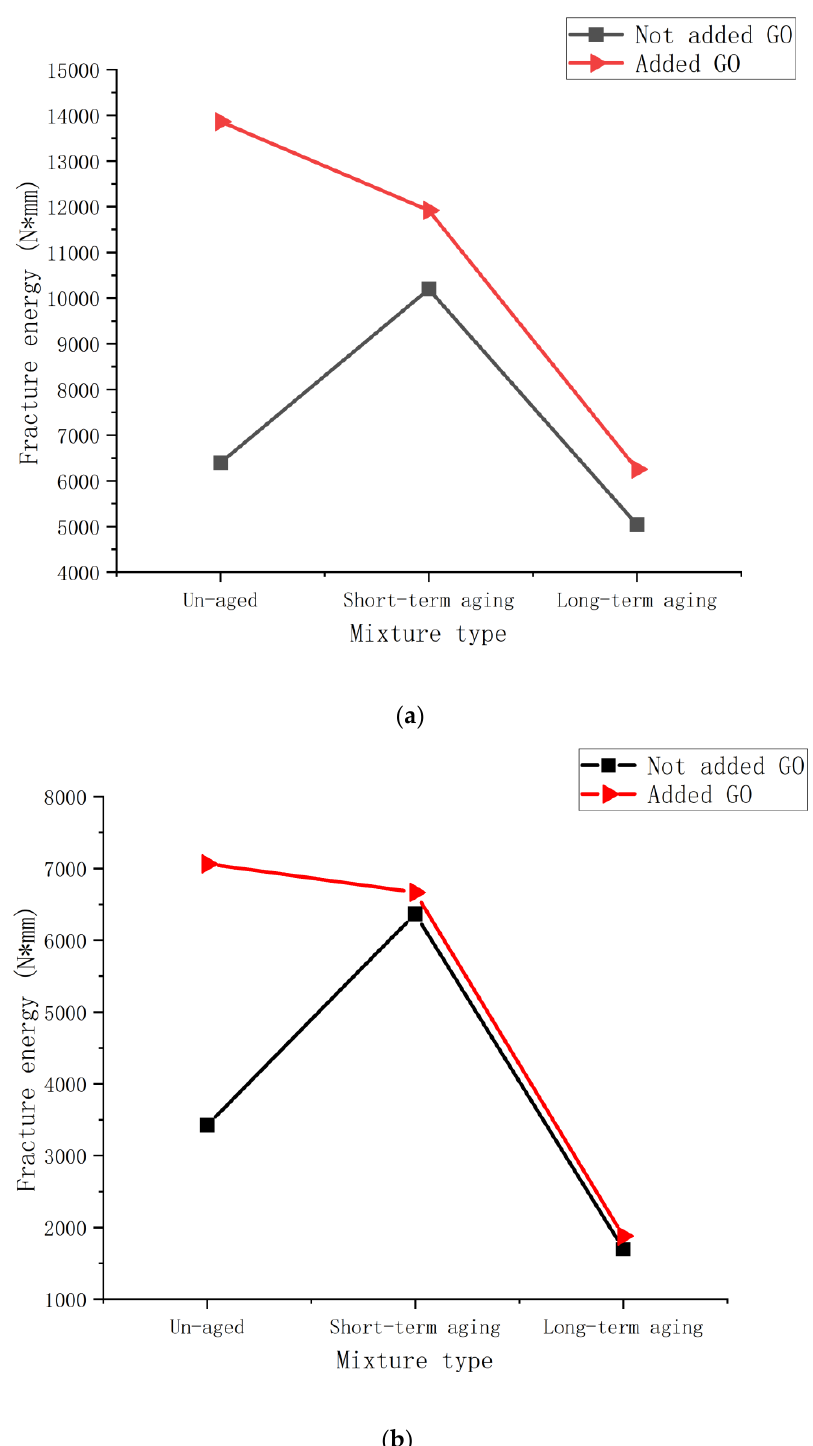
Figure 5. Fracture energy images of SCB specimens of asphalt mixes with different degrees of aging: ( a ) Fracture energy of uncut SCB specimens; ( b ) Fracture energy of cut SCB specimens.